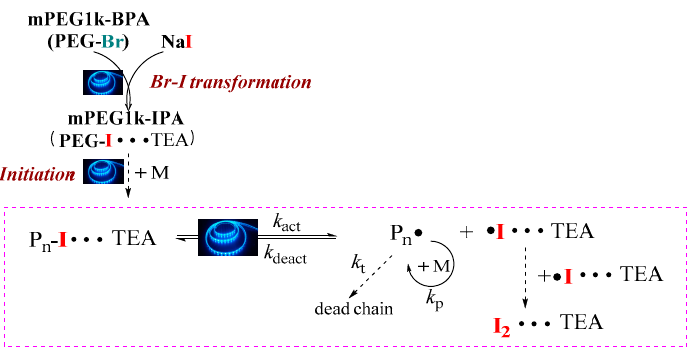
Scheme 4. Proposed polymerization mechanism by using one-step photo-BIT-RDRP strategy.